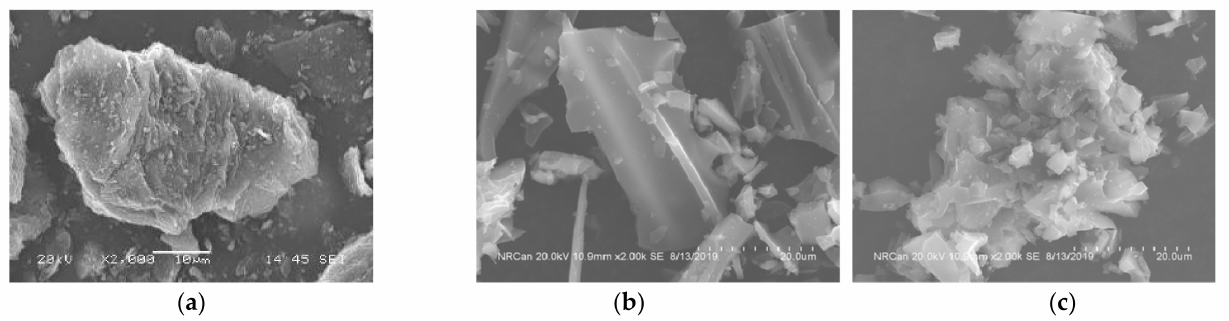
Figure 8. Surface morphology of: ( a ) coke, ( b ) loose softwood bio-char and ( c ) densified softwood